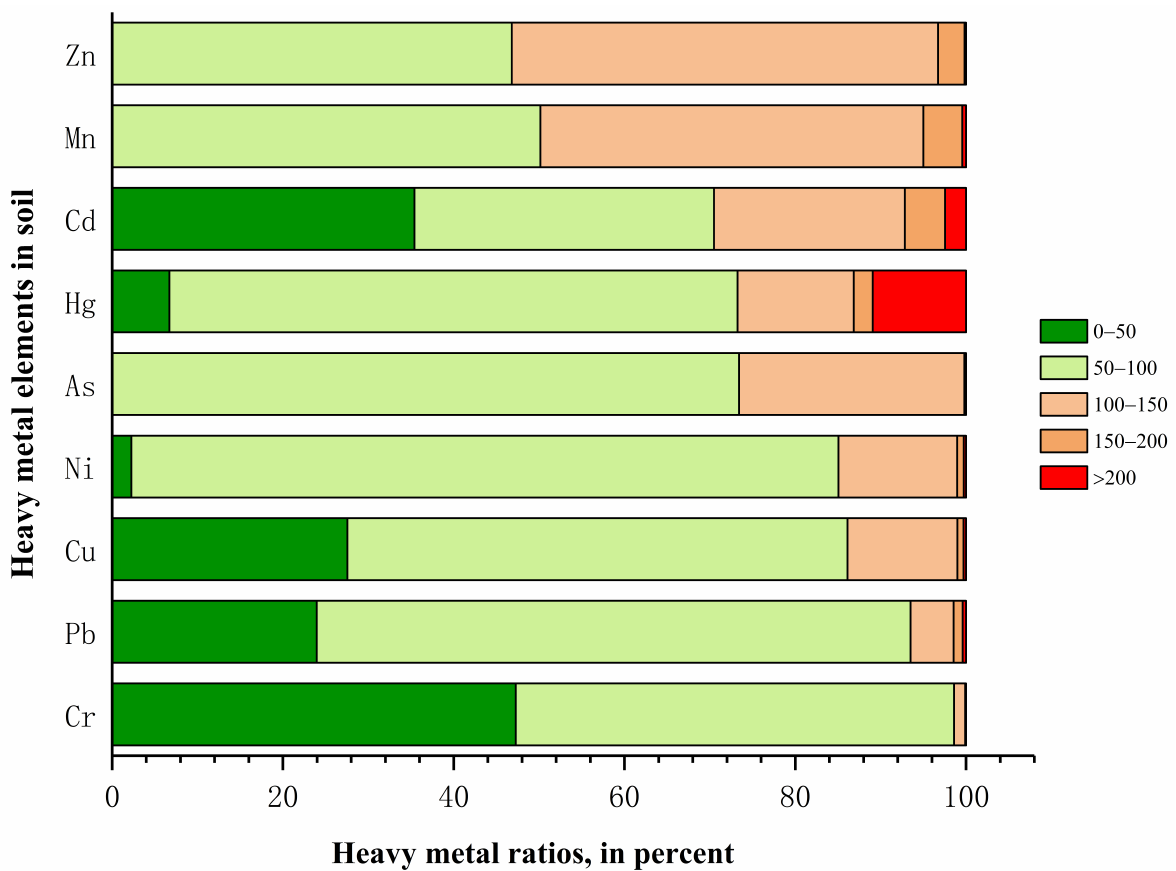
Figure 4. Percentage of soil samples with Zn, Mn, Cd, Hg, As, Ni, Cu, Pb, and Cr ratios (heavy metal element content/heavy metal background value × 100%) in Shaanxi Province. The classification standard of the ratios is as follows: level 1: the concentration is less than 50% of the background value (olive); level 2: the concentration is between 50% and 100% of the background value (50% olive); level 3: the concentration is between 100% and 150% of the background value (50% orange); level 4: the concentration is between 150% and 200% of the background value (orange); level 5: the concentration is greater than 200% of the background value